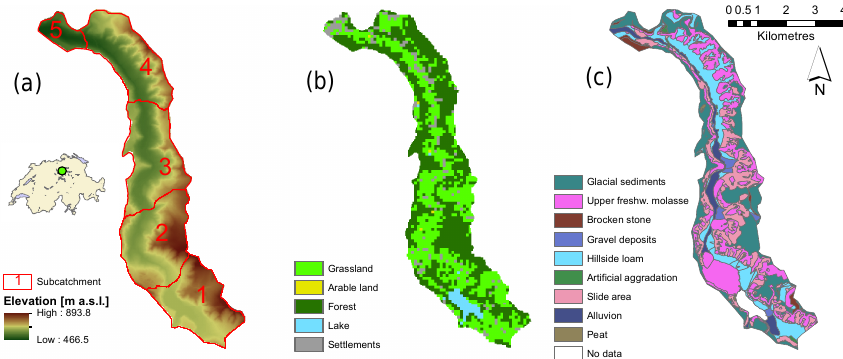
Figure 2. Overview of the Reppisch catchment, Switzerland. (a) Digital terrain model (25m resolution) subdivided into five sub-catchments; (b) land-use map (100m resolution); (c) geology map (data: BFS GEOSTAT/Federal Office of Topography swisstopo).